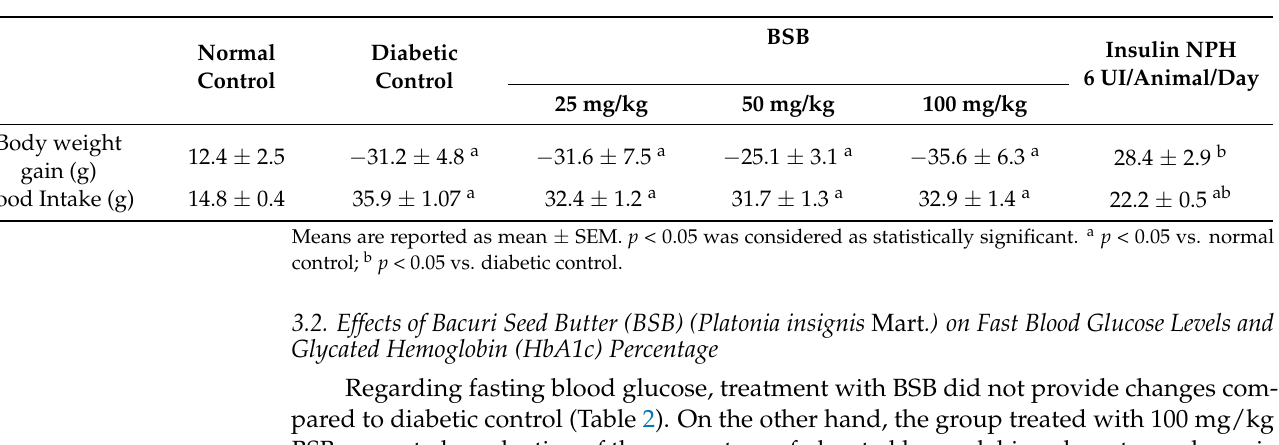
Table 1. Effect of bacuri seed butter ( Platonia insignis Mart.) on body weight and food intake of Wistar rats submitted to induction of diabetes